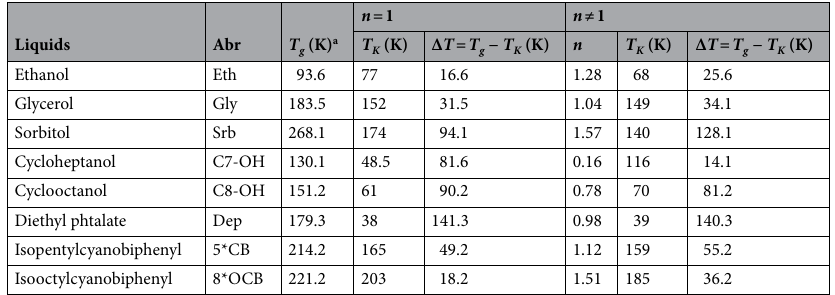
Table 1. Parameters calculated from the distortions-sensitive analysis. The T K was calculated directly from the Eq. (10), when the condition S C ( T ) → 0 ⇒ T | S C ( T ) = 0 = T K is fulfilled. a Glass temperature calculated for the relaxation time τ = 100 s.